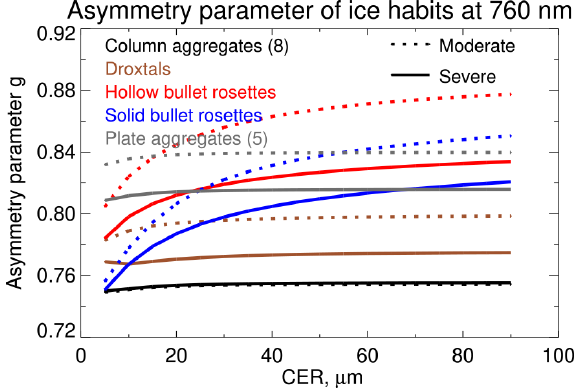
Figure 7. Ice crystal asymmetry factor at 760nm as a function of CER. Colours indicate different ice crystal habits; dashed and solid lines refer to moderately and severely roughened crystals respec-